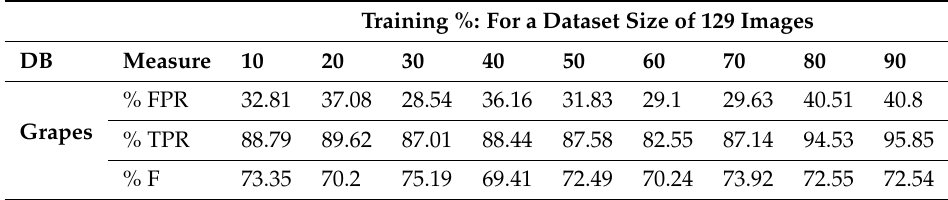
Table 7. Performances vs. different % images database as the training